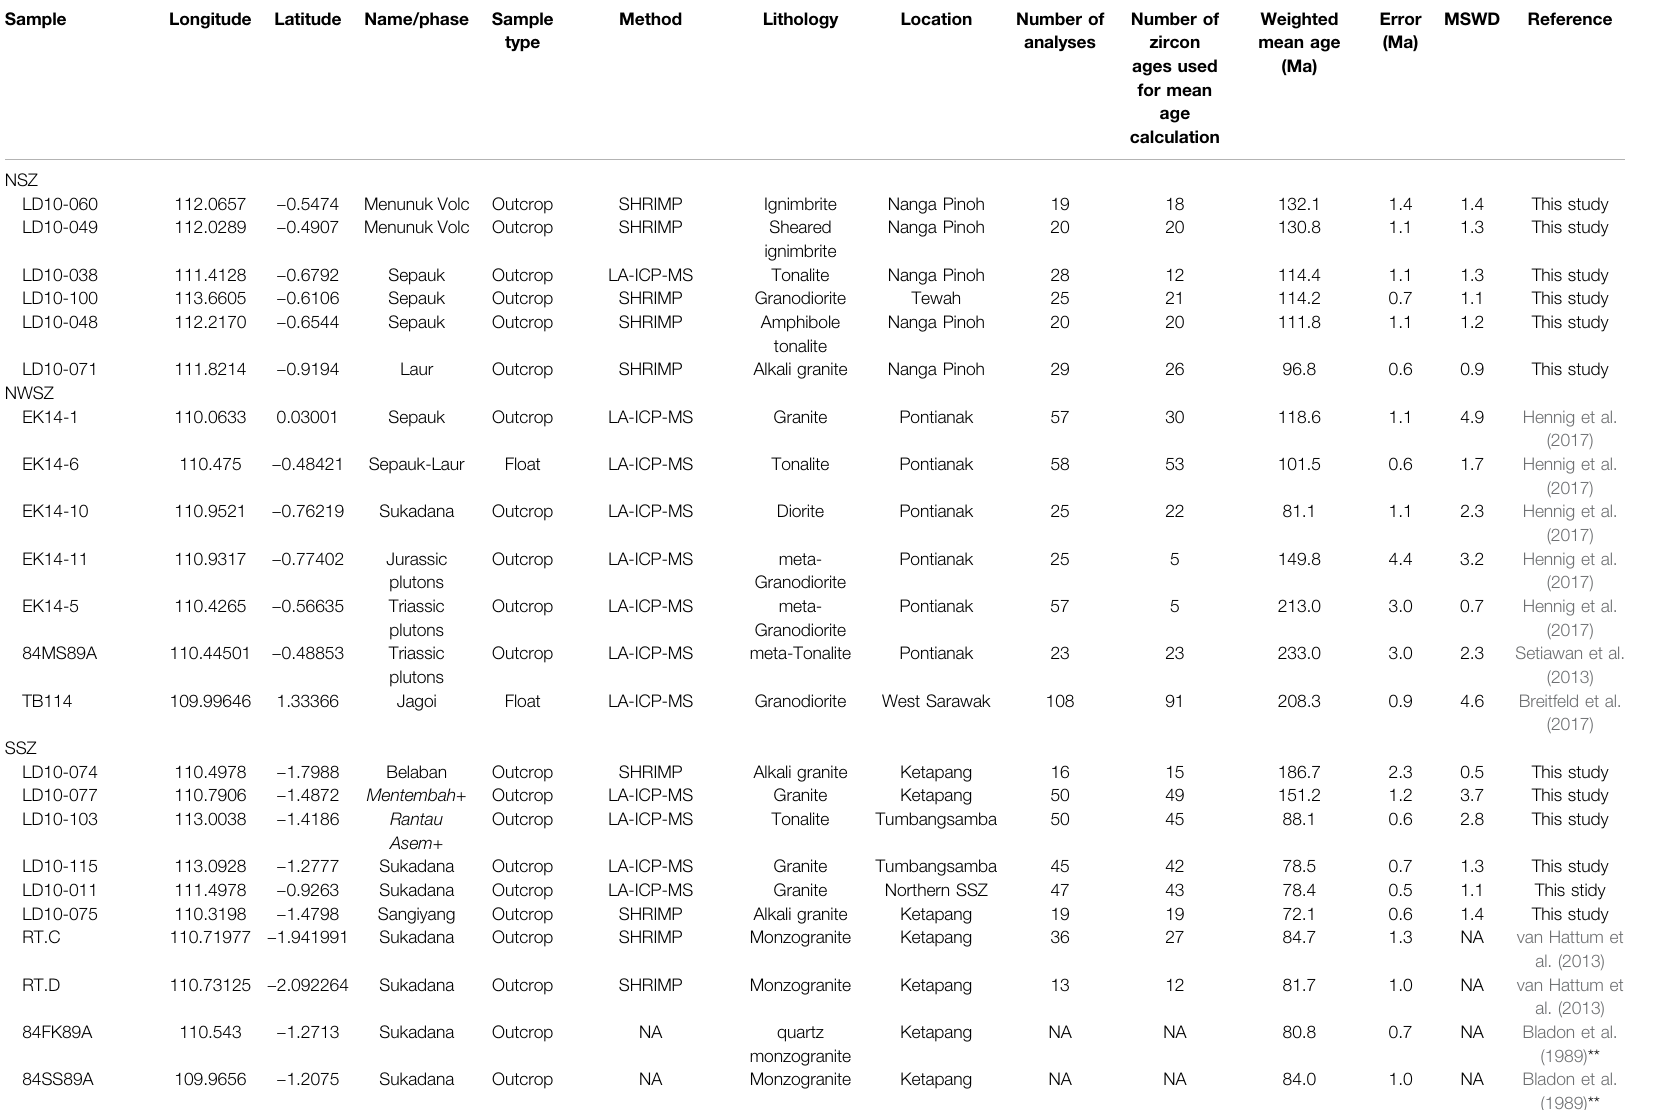
TABLE 2 | Zircon U-Pb ages of this study and literature data from the igneous and metamorphic rocks of the Schwaner Mountains. PMG samples marked with * are ages calculated with the unmix function of Isoplot and representtheigneousprotolithagesandmetamorphic overprint.SamplesfromBladonetal.(1989)aremarkedwith**becausethereisnoinformationgivenonhowmanyzirconswereanalysed. + marksinformalnames for new plutons found in this